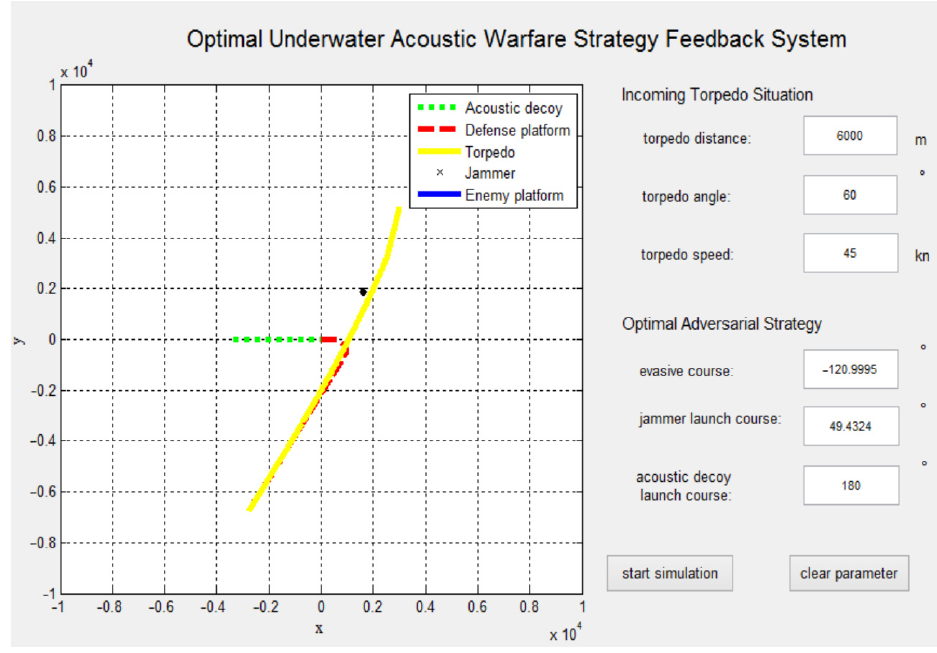
Figure 17. The optimal underwater acoustic warfare strategy feedback system interface. Table 2. The optimized neural network performance.